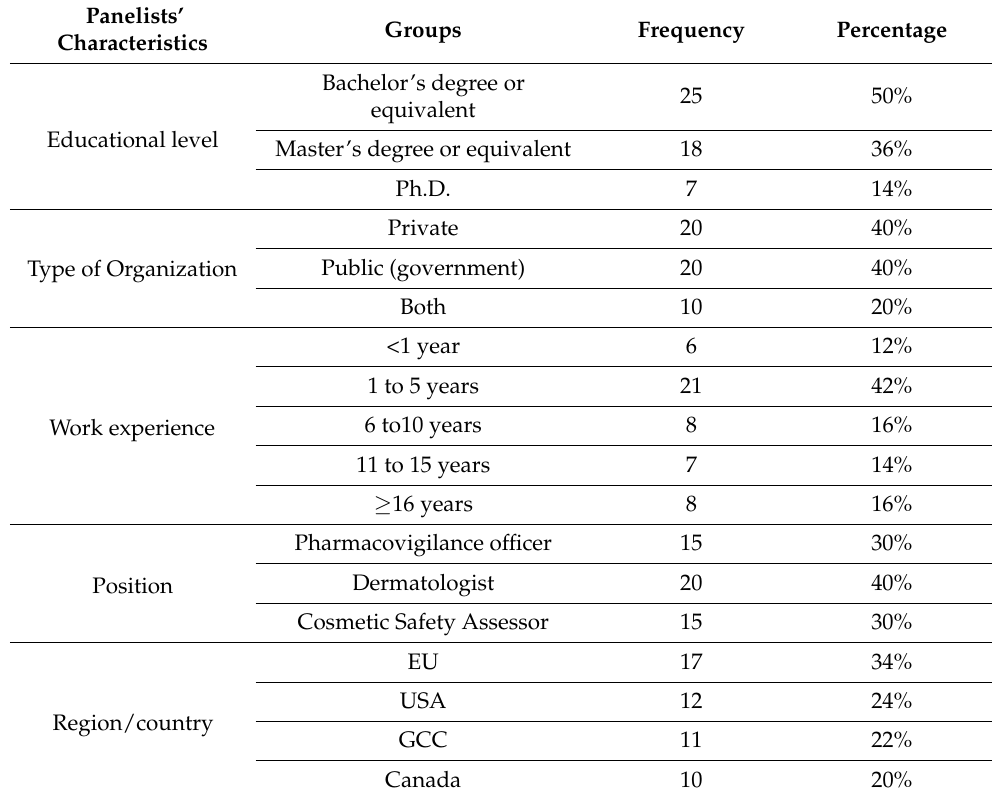
Table 1. Panelists’ baseline information ( n =